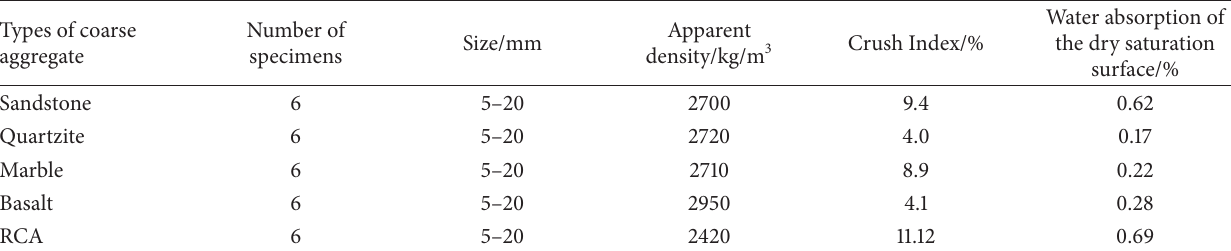
Table 1: Test results of coarse aggregate quality.